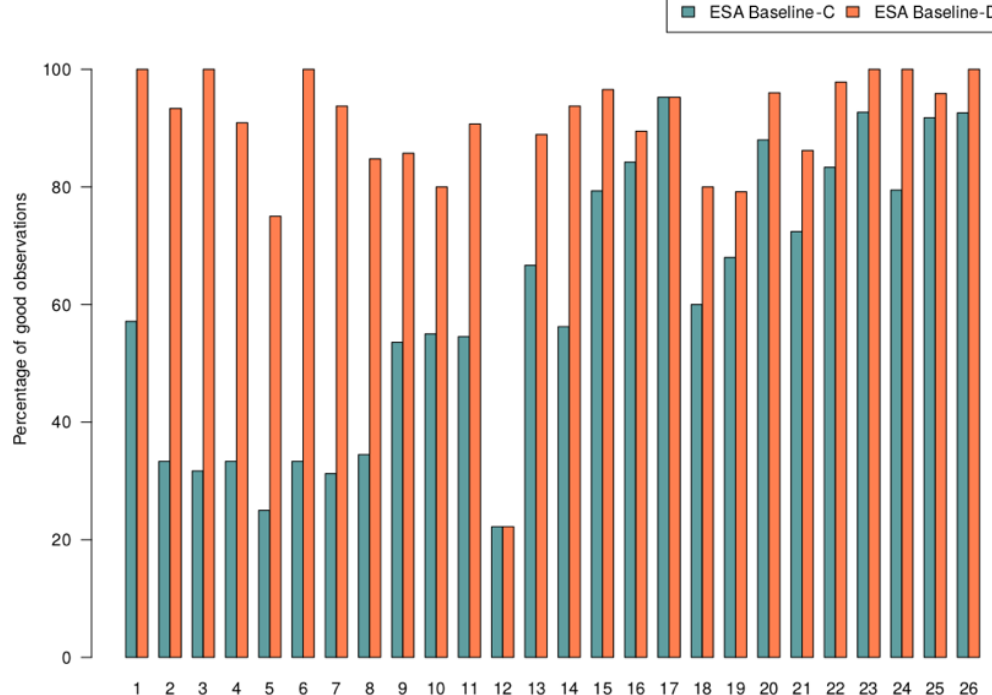
Figure 14. The percentage of good measurements for Baseline-C (blueish) and Baseline-D (coral) based on 26 tracks covering 15 Swedish